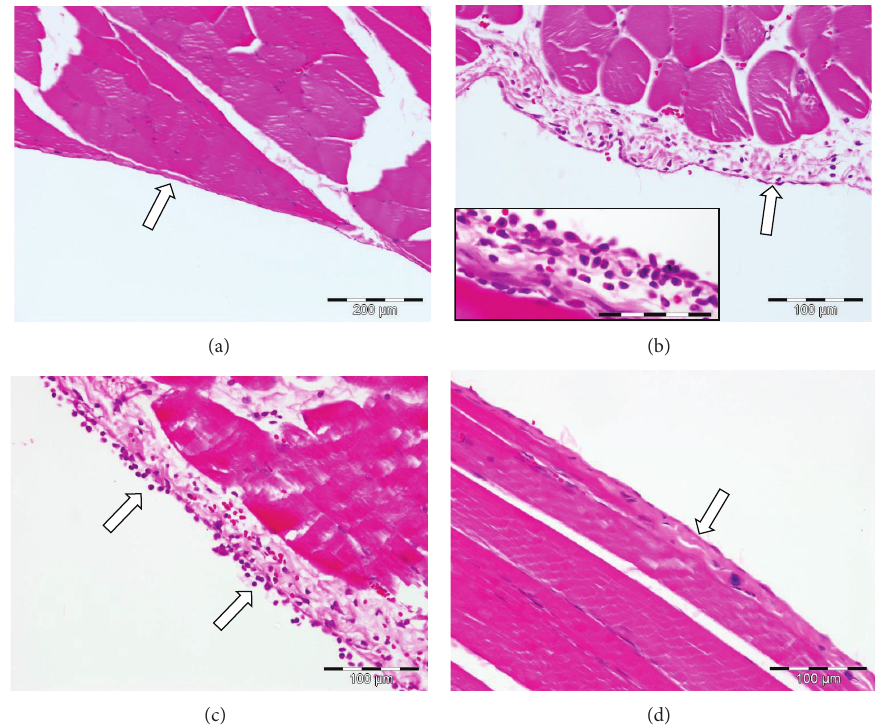
Figure1:Selectedlightmicrographsshowingthemesothelialsurface12 hafterinsufflationwithCO 2 for2hat5mm/Hgof(a)controlanimals, no treatment with CO 2 ; (b) insufflation with room-temperature, dry CO 2 where inflammatory cells are evident in the lamina propria. Inset: inflammatory cells on surface of mesothelium (scale bar = 100 𝜇 m); (c) insufflation with heated, dry CO 2 . Inflammatory cells are evident on the mesothelial surface; (d) insufflation with warm, humidified CO 2 with normal mesothelium. Arrows indicate the mesothelial surface.